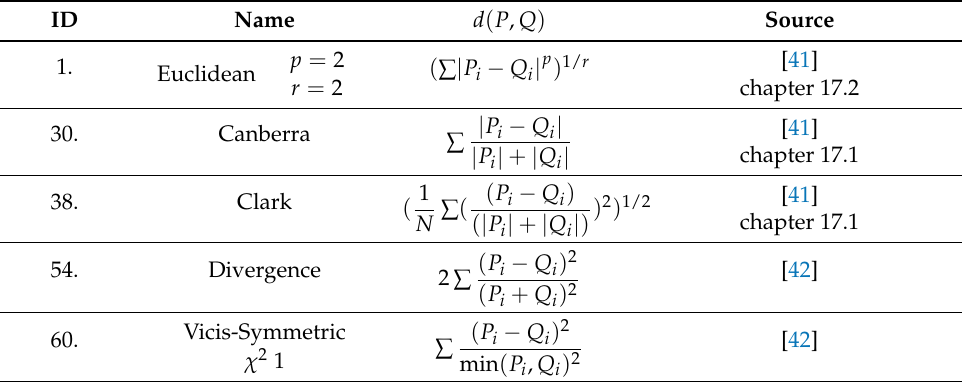
Figure 4. Misclassification rates of all runs (CV1 to CV5) and average misclassification rates. Legends are the same as in Figure 3. Table 2. Selected distance measures. d ( P , Q ) is the distance between vectors P and Q